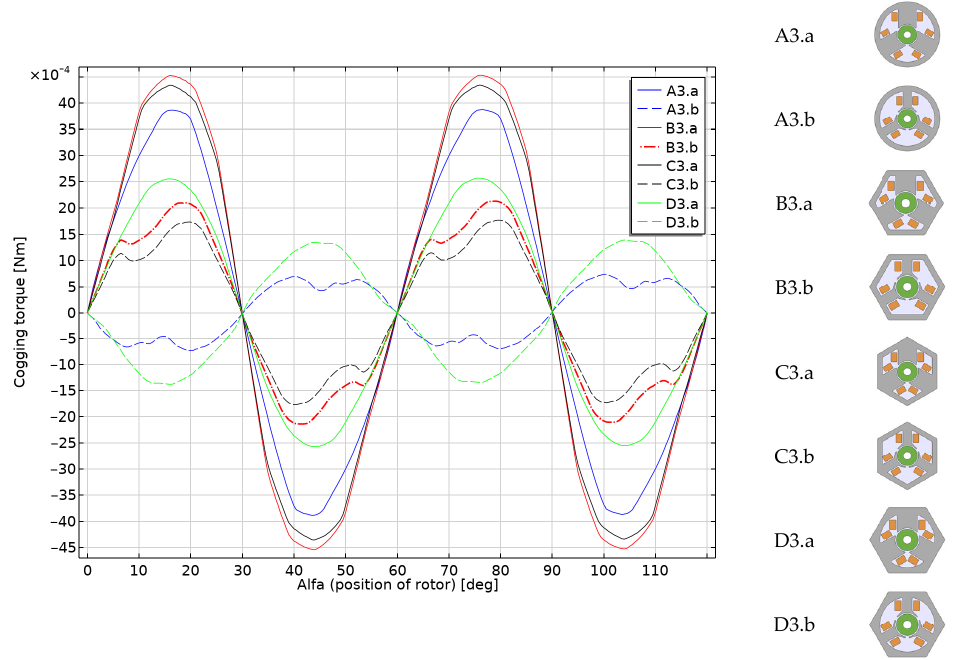
Figure 17. Cogging torque (Nm) for the rotor position from 0° to 120° for all models.